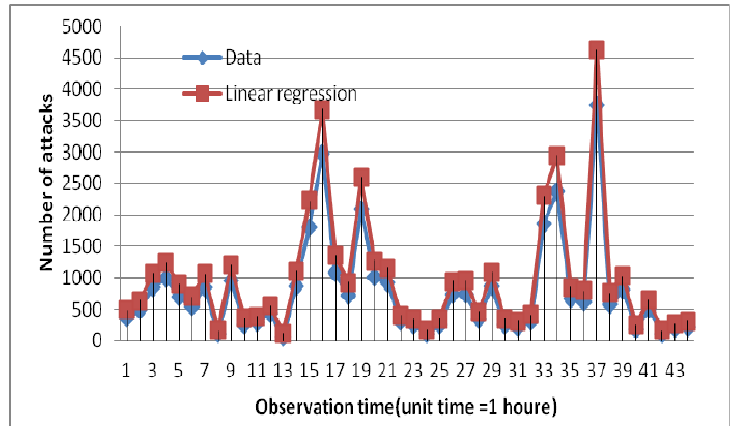
Fig.11. The observed and estimated number attack evolution per unit time by considering